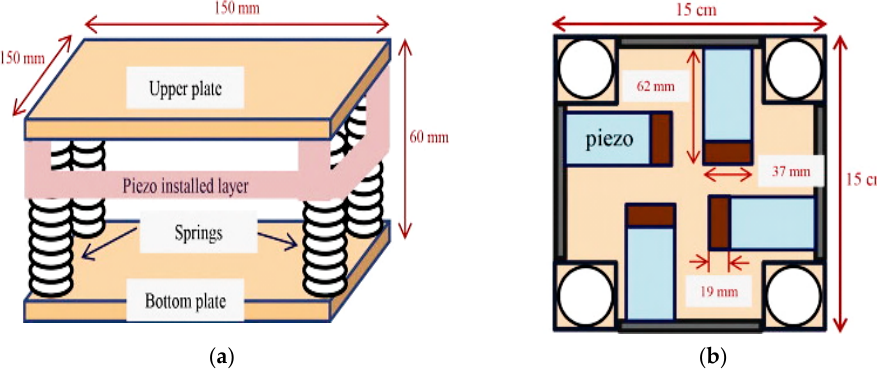
Figure 15. Graphic representation of the piezoelectric tile ( a ) and a close-up of the piezoelectric modules installed on the center plate ( b ) [53].